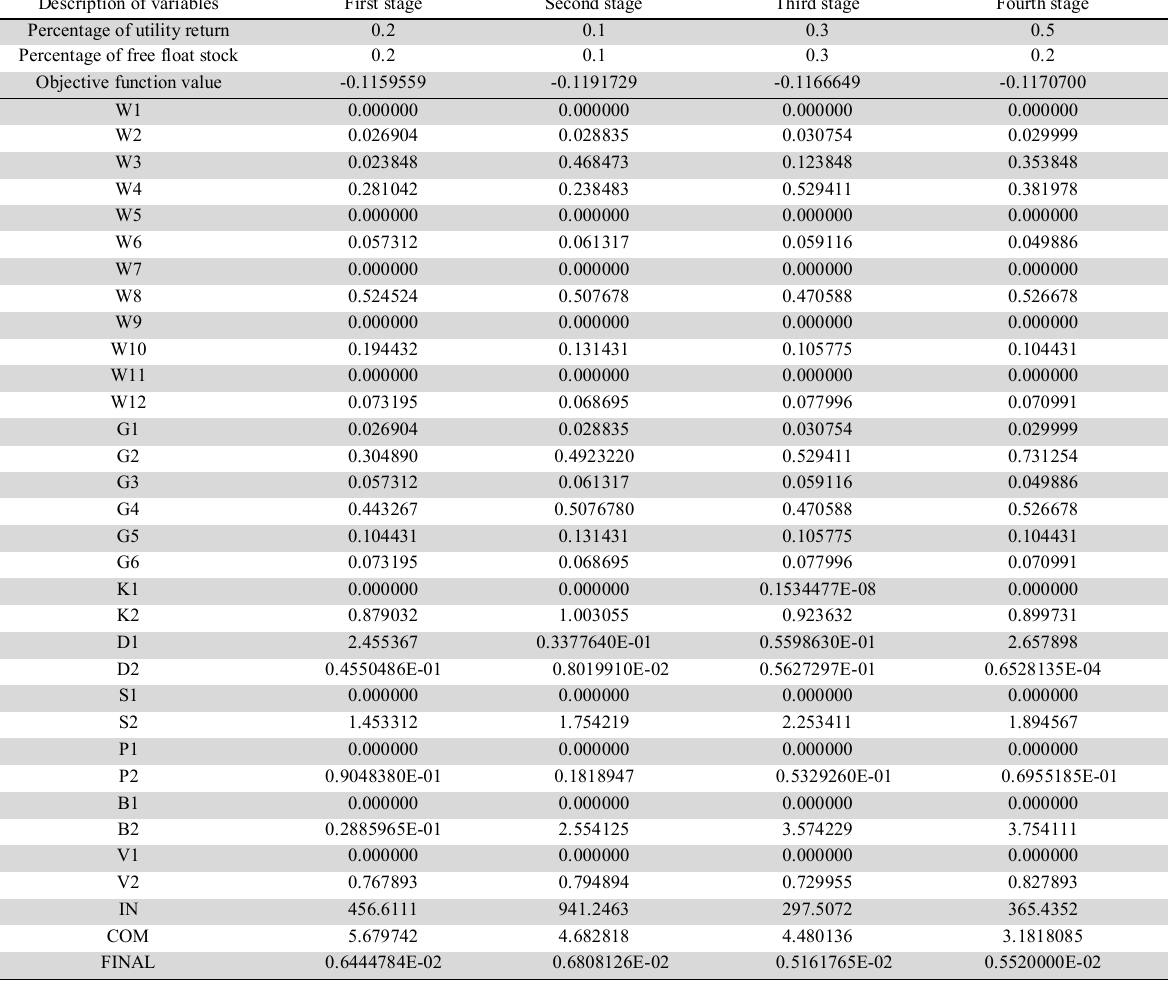
The summary of portfolio optimization under four different scenarios